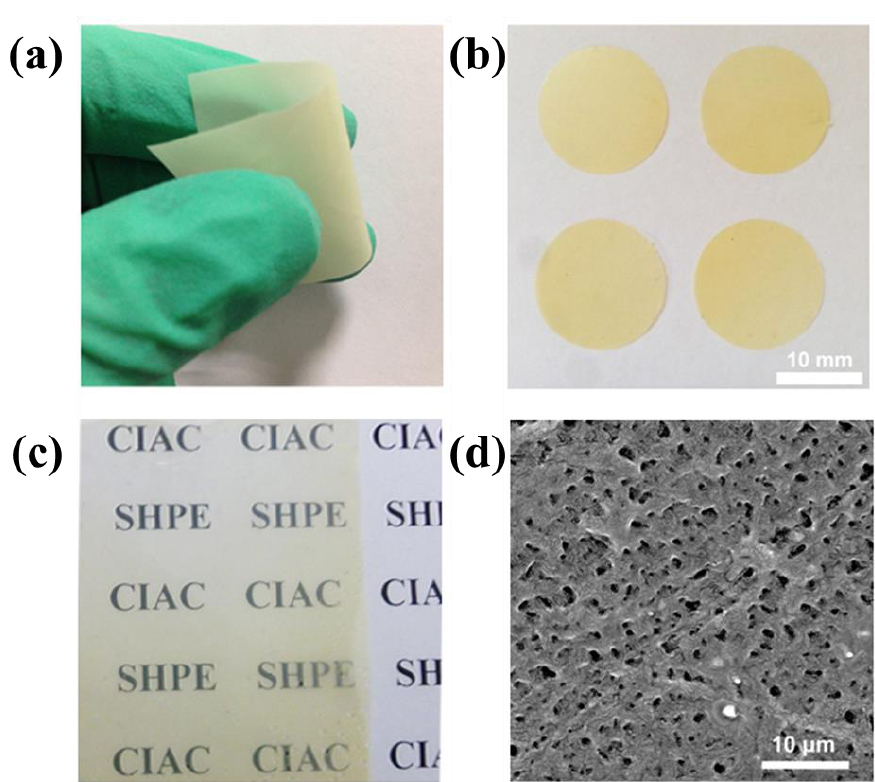
Figure 3. ( a ) Optical image of the flexible SHP electrolyte membrane. ( b ) Optical image of the SHP electrolyte membranes 20 μm in thickness. ( c ) The transparency of the SHP electrolyte membranes (the thickness of the membranes is 10μm). ( d ) SEM image of the SHP electrolyte membrane.